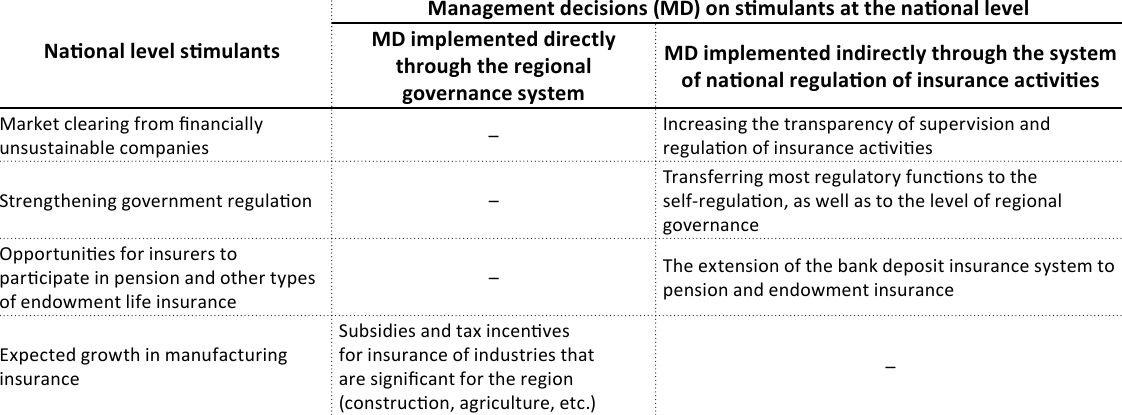
Table 5. Example of managing national stimulants of the insurance market that affect the RIM development